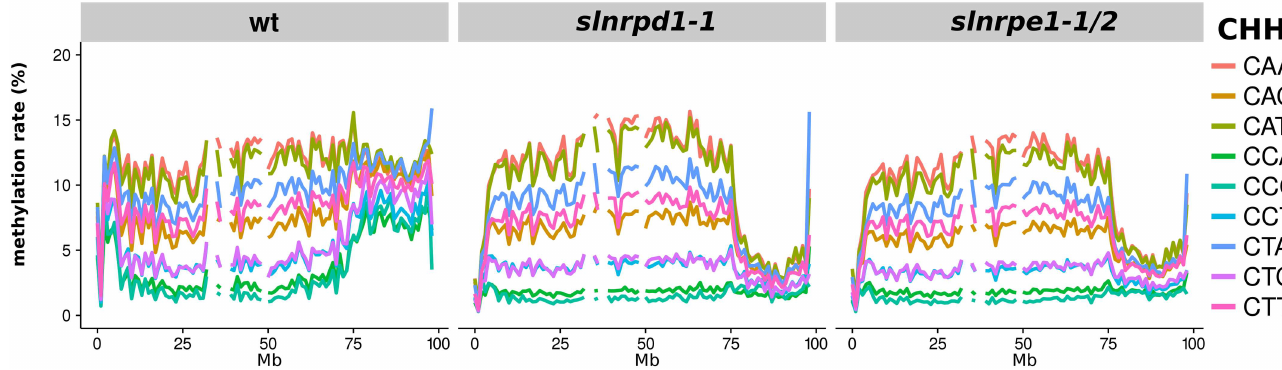
Fig 5. DecreasedCHH methylation in the chromosome arms of tomato RdDM mutants. Chromosome 1 is